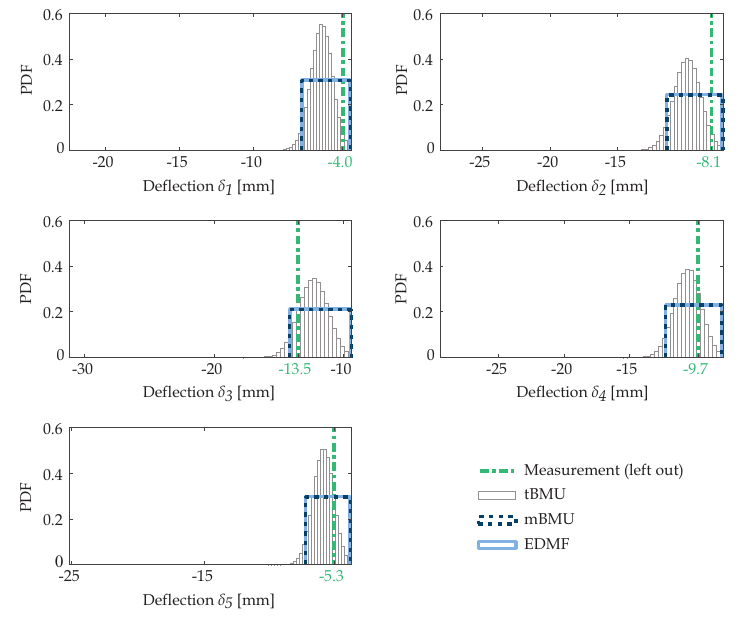
Figure 12. Leave-one-out cross validation for the five deflection measurements used in Scenario 2. mBMU and EDMF were accurate for all five measurements, while the measurements fell outside 95th-percentile bounds for deflection δ 1 in the case of